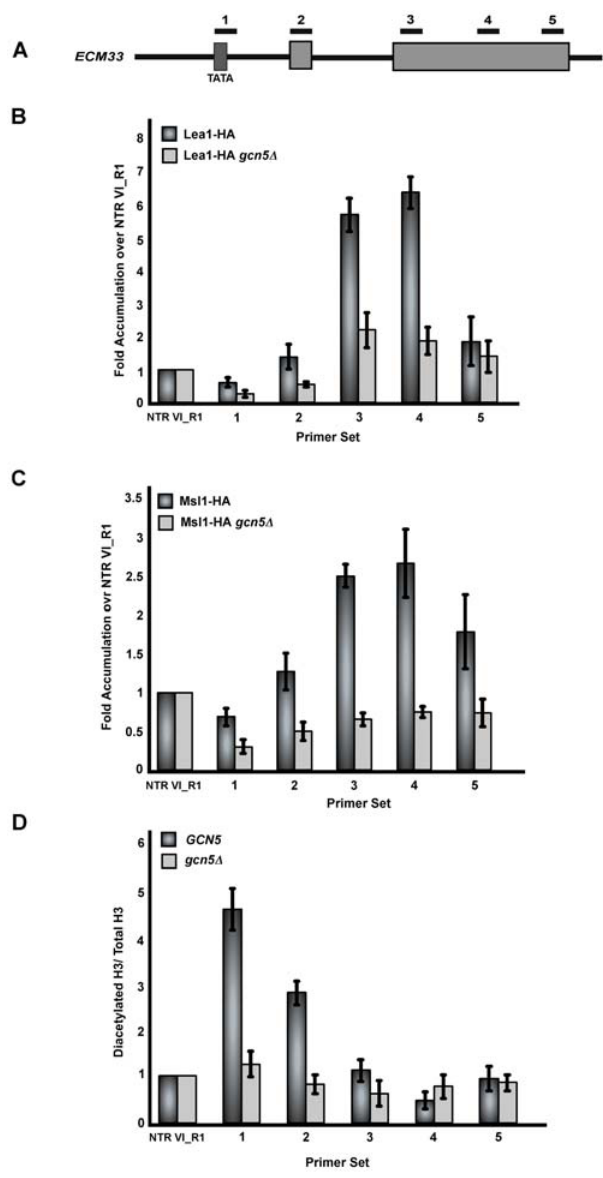
Figure 6. Deletion of GCN5 affects co-transcriptional recruit- ment of Msl1 and Lea1 to ECM33 and histone H3 acetylation. (A) Schematic of the intron-containing gene, ECM33 . Underlined numbers represent the amplicons generated from each primer set used in the study. (B) Graph depicting the occupancy of Lea1 at each region of ECM33 relative to the non-transcribed region, in wild-type or gcn5 D cells. Dark grey bars represent Lea1 with wild-type GCN5 , and light grey bars represent Lea1 levels in the gcn5 D strain. (C) Bar graph depicting Msl1- HA occupancy within ECM33 relative to the non-transcribed control. Dark grey bars represent Msl-HA with wild-type GCN5 and light grey bars represent Msl1-HA occupancy in the gcn5 D strain. Data are represented as fold accumulation over the non-transcribed region. (D) ChIP analysis of histone H3 K9/14 acetylation in ECM33 of wild-type and gcn5 D strains using an antibody against diacetylated histone H3. Dark grey bars represent wild-type and light grey bars represent histone acetylation in a gcn5 D strain. Data are represented as diacetylated histone H3 normalized to the total amount of histone H3 (Total H3). Graphs depict the average of three independent experiments, and error bars represent the standard deviation.